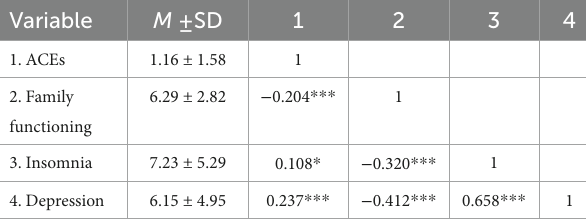
TABLE 2 Means, standard deviations, and correlation of ACEs, family functioning, insomnia and depression ( N = 368).